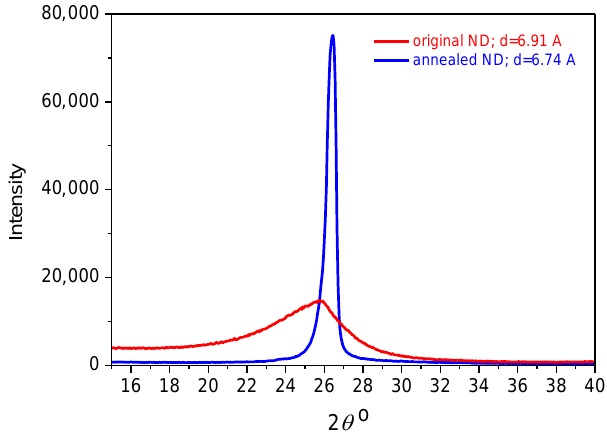
Figure 7. WAXS diffractograms of the original and annealed nanodiscs.